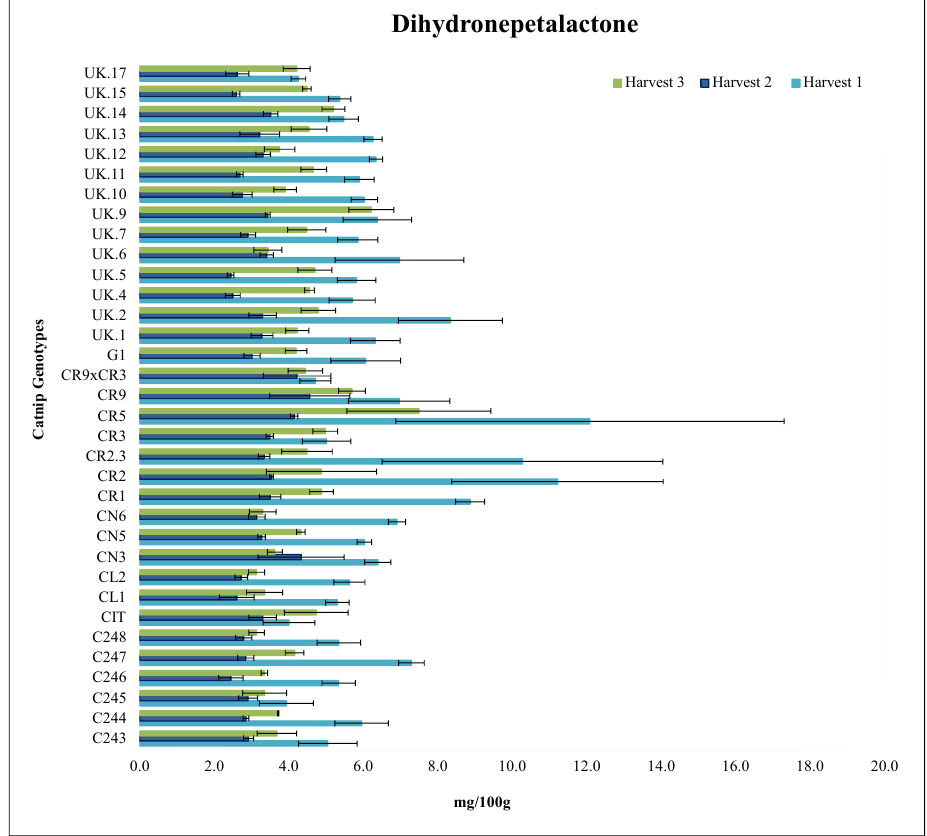
Figure 4. Dihydronepetalactone (DHNL) content (mg/100 g) of catnip genotypes at three different harvest times. Pittstown, NJ, USA, 2017 and 2018. Error bars represent standard error. Harvest 1 = July 2017, Harvest 2 = September 2017, Harvest 3 = June 2018. De-tailed statistical analyses of the interaction effects are presented in the Supplementary material Table S4.